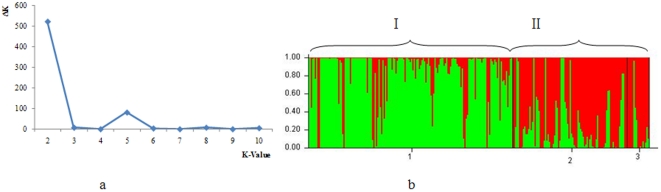
Population structure analysis of 262 wheat cultivars based on 42 unlinked SSR loci.a: Population structure as determined by Structure v2.2 analysis. Since Δk peaks at k = 2, the varietal set was split into two sub-groups. b: Structure analysis reveals that the 262 wheat cultivars are clustered into two sub-populations. I. Landrances. II. Modern varieties and introduced lines.